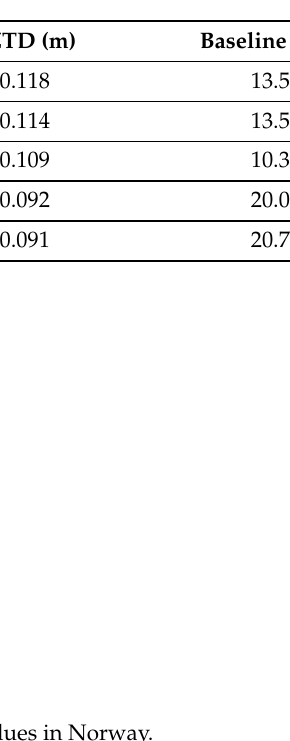
Figure 10. Locations of 10 events with the highest dZTD values in Norway.